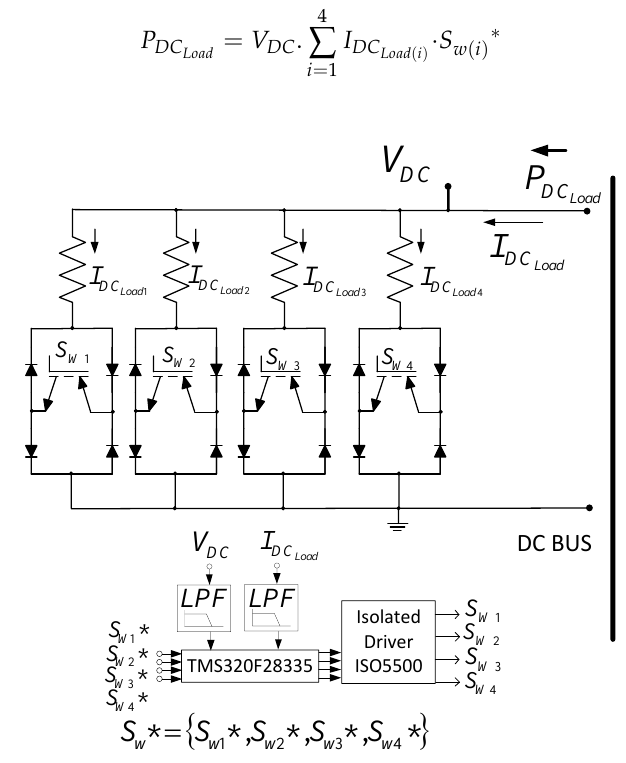
Figure 5. Topology of the electronics switches.